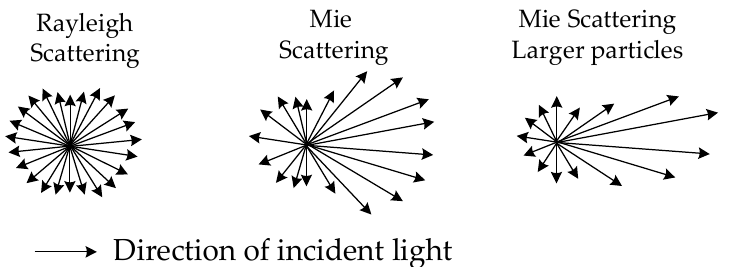
Figure 4. Relationship between size and scattered light intensity distribution.